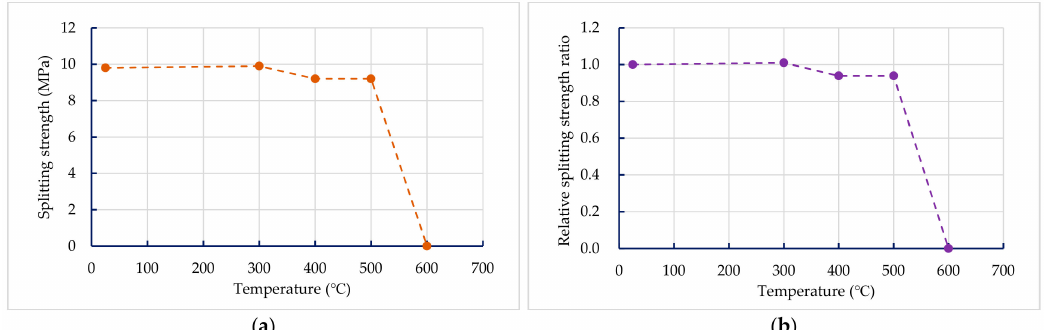
Figure 12. Comparison of splitting strength before and after fire damage to the UHPC-1 specimen: ( a ) residual splitting strength after high temperature; ( b ) relative splitting strength